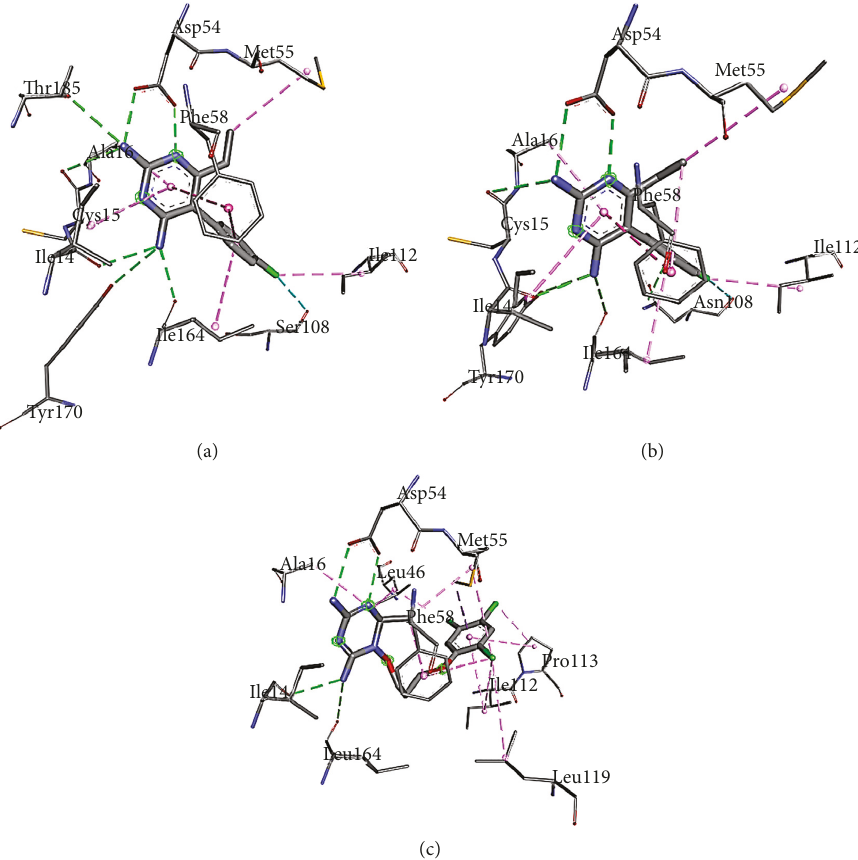
Figure 4: 3D X-ray crystal structures of ligands in the DHFR variants. (a) Pyrimethamine in the wild-type DHFR; (b) pyrimethamine in the double mutant DHFR; (c) WR99210 in the quadruple mutant DHFR. Table 2: Molecular docking result of pyrimethamine and Cryptolepis sanguinolenta alkaloids with wild-type Pf DHFR (3QGT). Binding energies (kcal/ Alkaloids